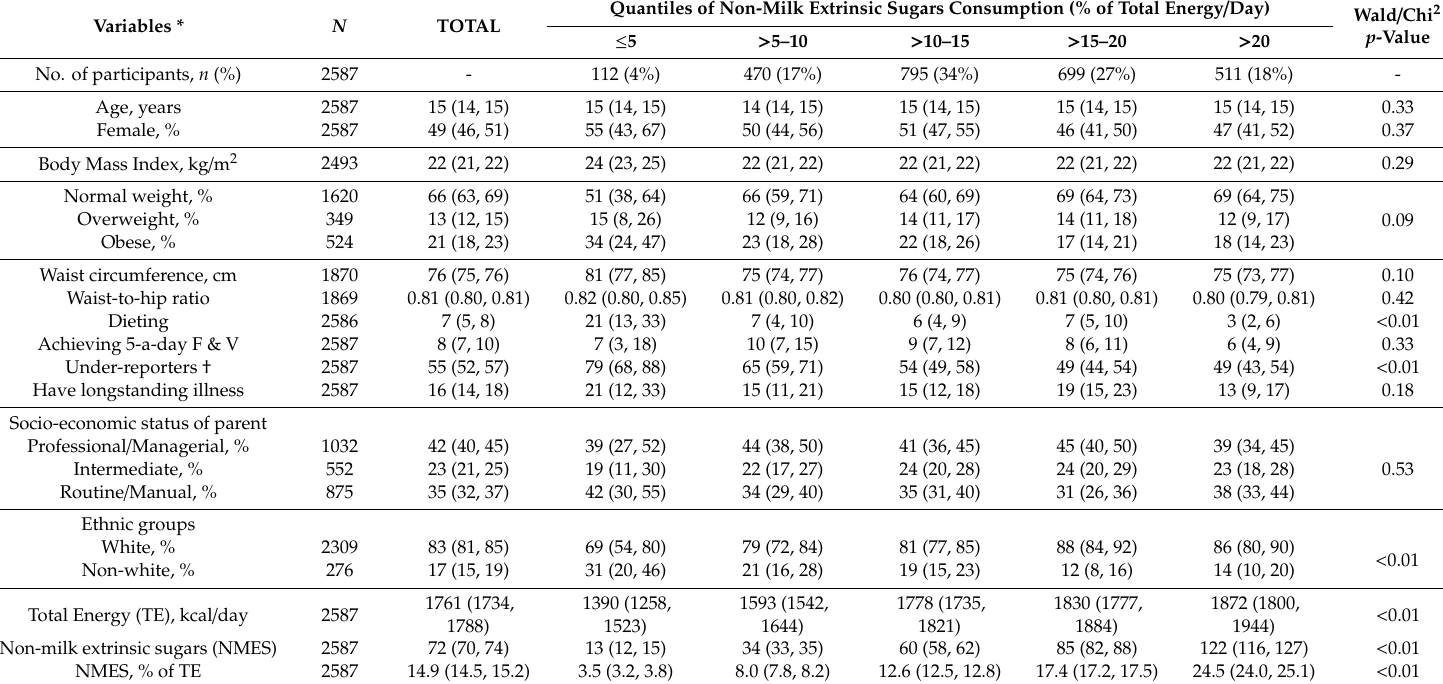
Table 1. Characteristics of adolescents aged 11 to 18 years in the National Diet and Nutrition Survey Y1-8 by category of non-milk extrinsic sugar consumption as a percentage of total energy after the application of Y1-8 survey weights ( n =